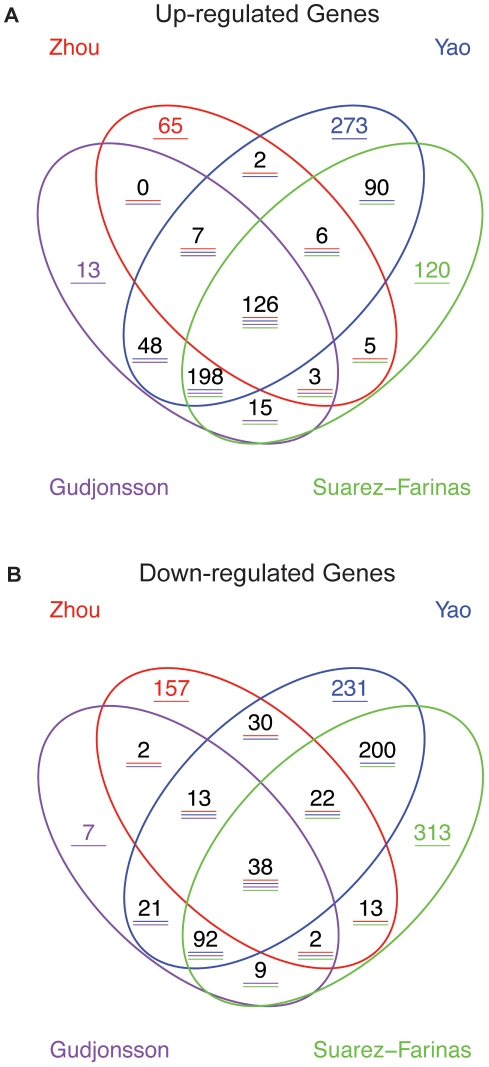
Comparison of four psoriasis transcriptomes.
A. Venn diagram showing the comparison of the number of up-regulated genes in common and distinct for the four studies. B. Venn diagram showing the comparison of the number of down-regulated genes in common and distinct for the four studies.